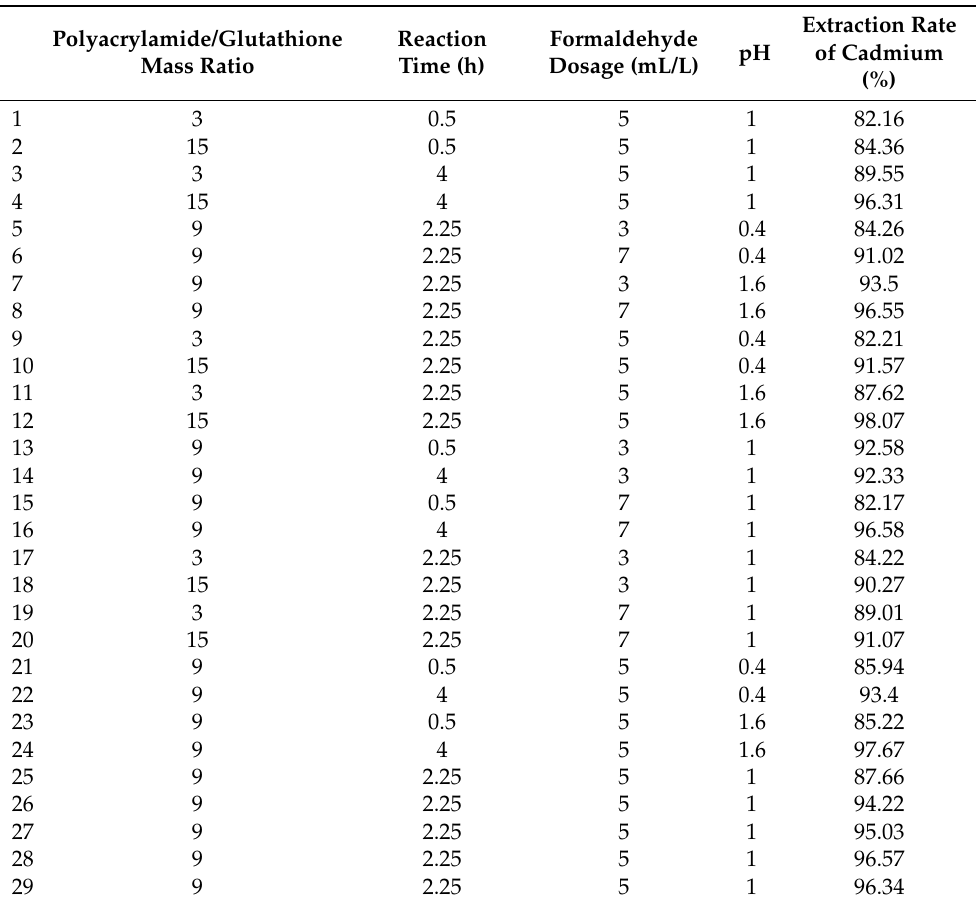
Table 2. Response surface experimental design and result.